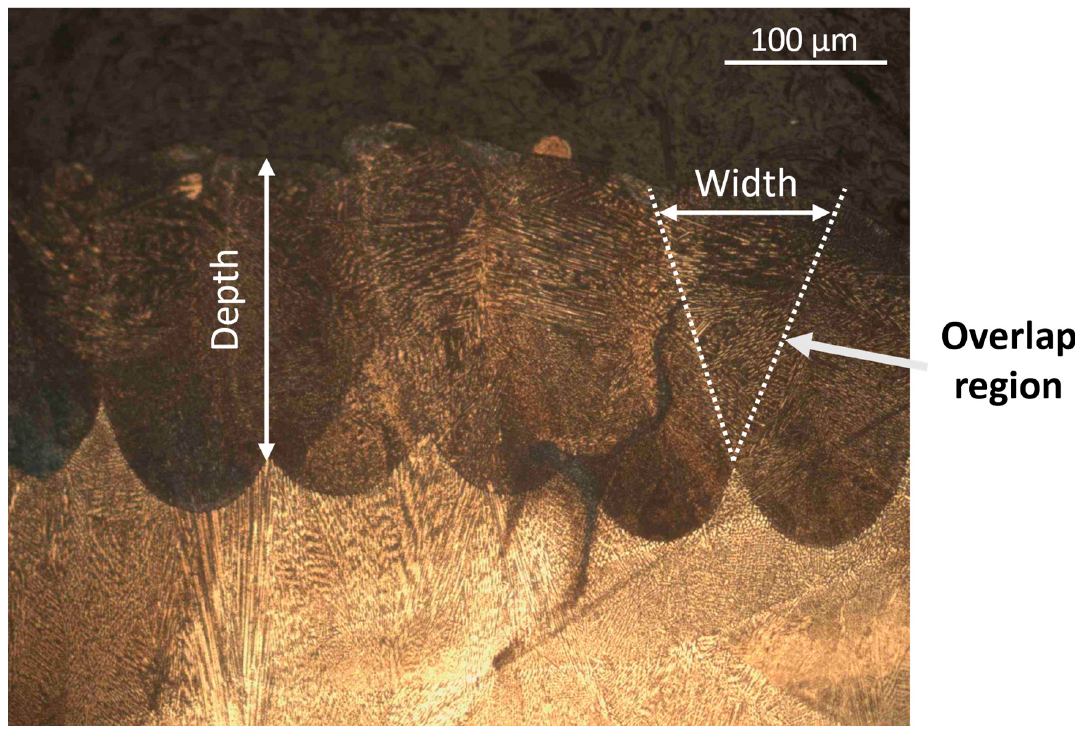
Figure 11. Overlap width and depth measurements.